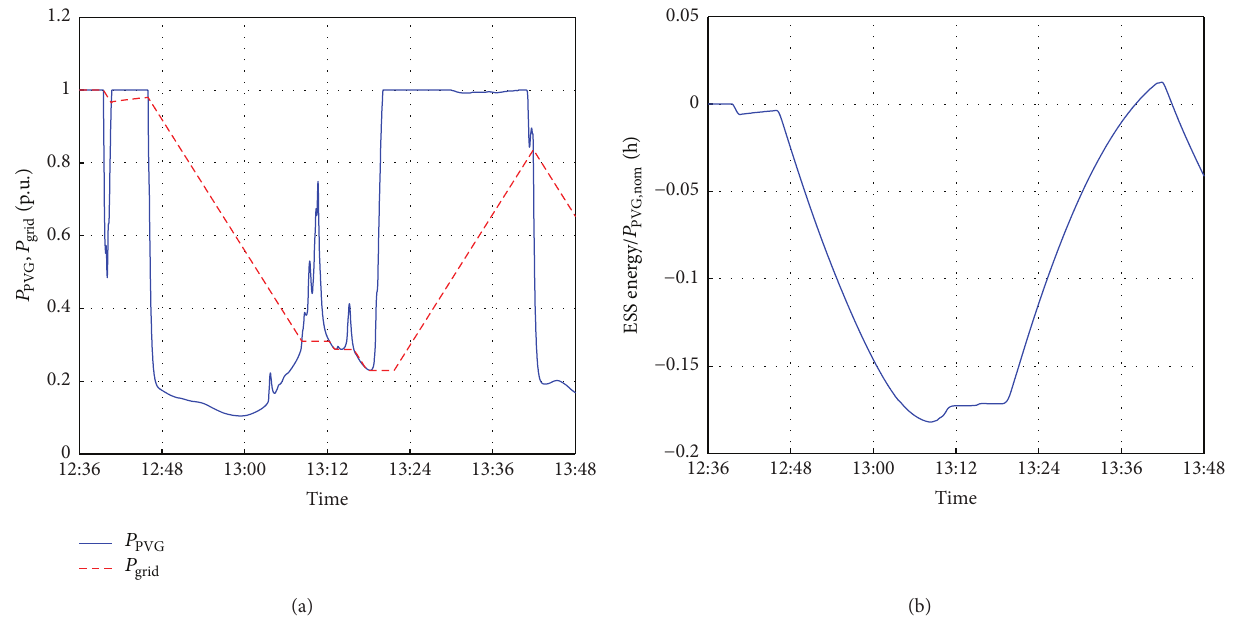
Figure 6: (a) 0.55 MWp PV generator and grid feed-in power and (b) the ESS energy during the formation of the minimum ESS energy with respect to the reference level causing the maximum absolute ESS capacity requirement of the TUT simulations on 09.04.2012 while complying with RR limit of 3%/min.